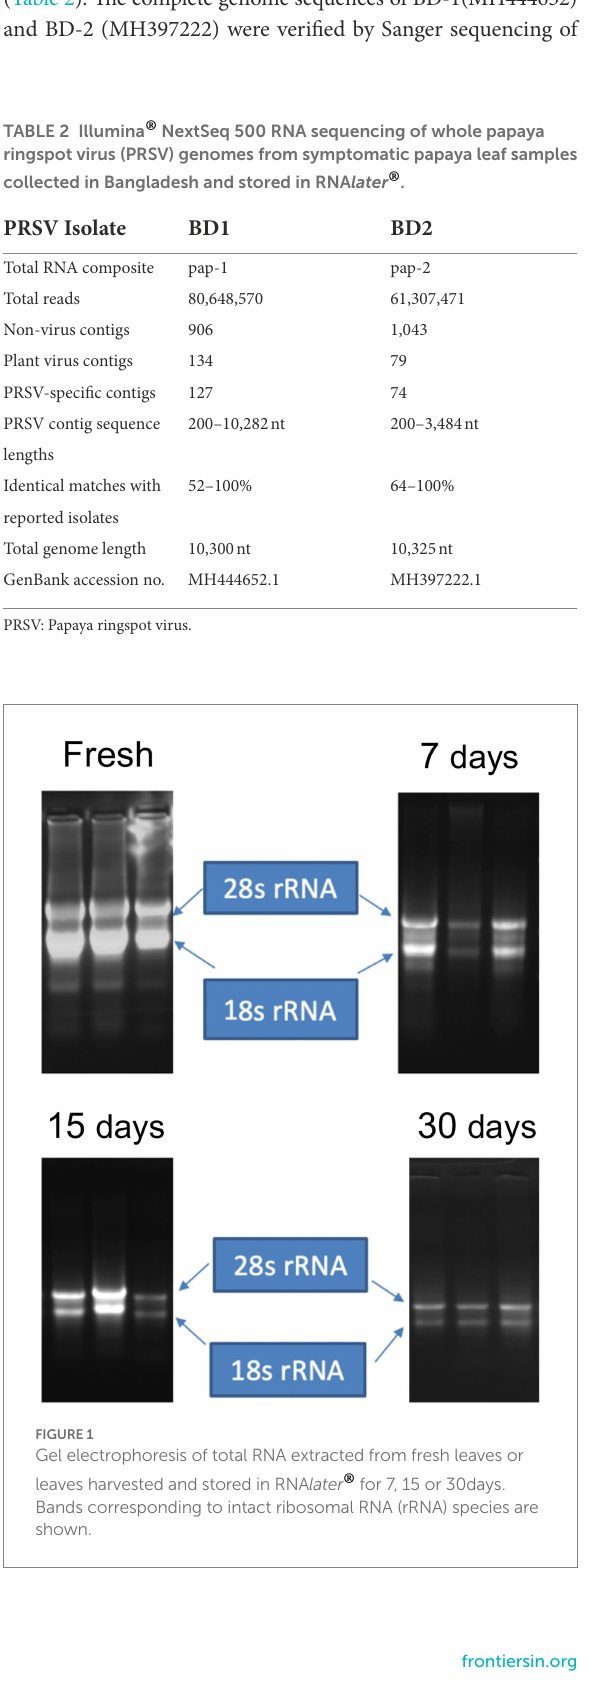
(Table 2). The complete genome sequences of BD-1(MH444652)